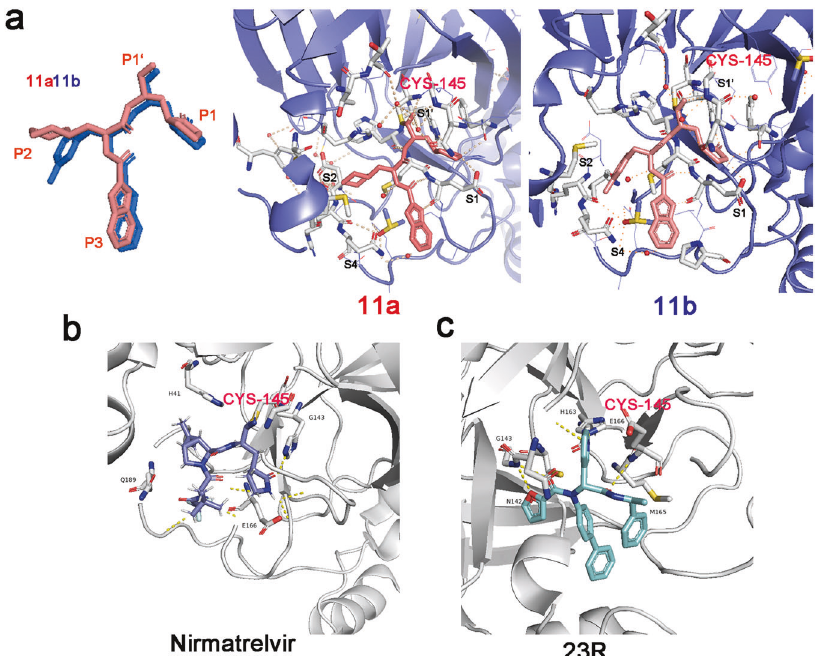
Fig. 4 Different binding models of inhibitors in complex with SARS-CoV-2 M pro . a Binding models of inhibitors 11a and 11b complexing with SARS-CoV-2 M pro (the Protein Data Bank entries for SARS-CoV-2 M pro complexing with 11a and 11b are 6LZE and 6M0K, respectively 70 ) b Binding model of inhibitor nirmatrelvir in complex with SARS-CoV-2 M pro (Protein Data Bank entry 7RFW). 84 c Binding model of non- covalent inhibitor 23R in complex with SARS-CoV-2 M pro (Protein Data Bank entry 7KX5 77